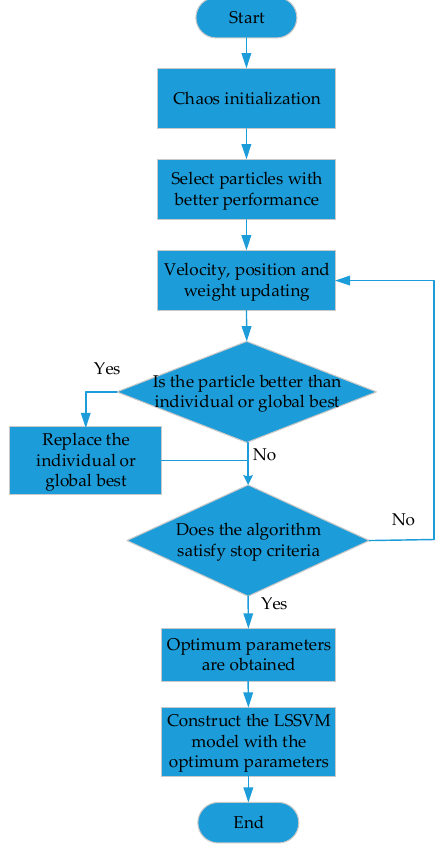
Figure 4. The flow chart of CPSO (chaotic particle swarm optimization)-LSSVM.